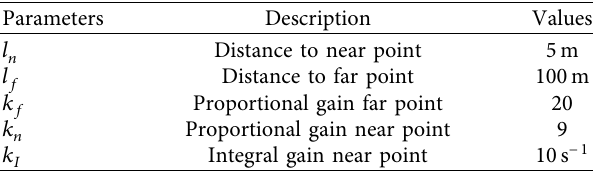
Table 4: Parameters setting of two-point visual control